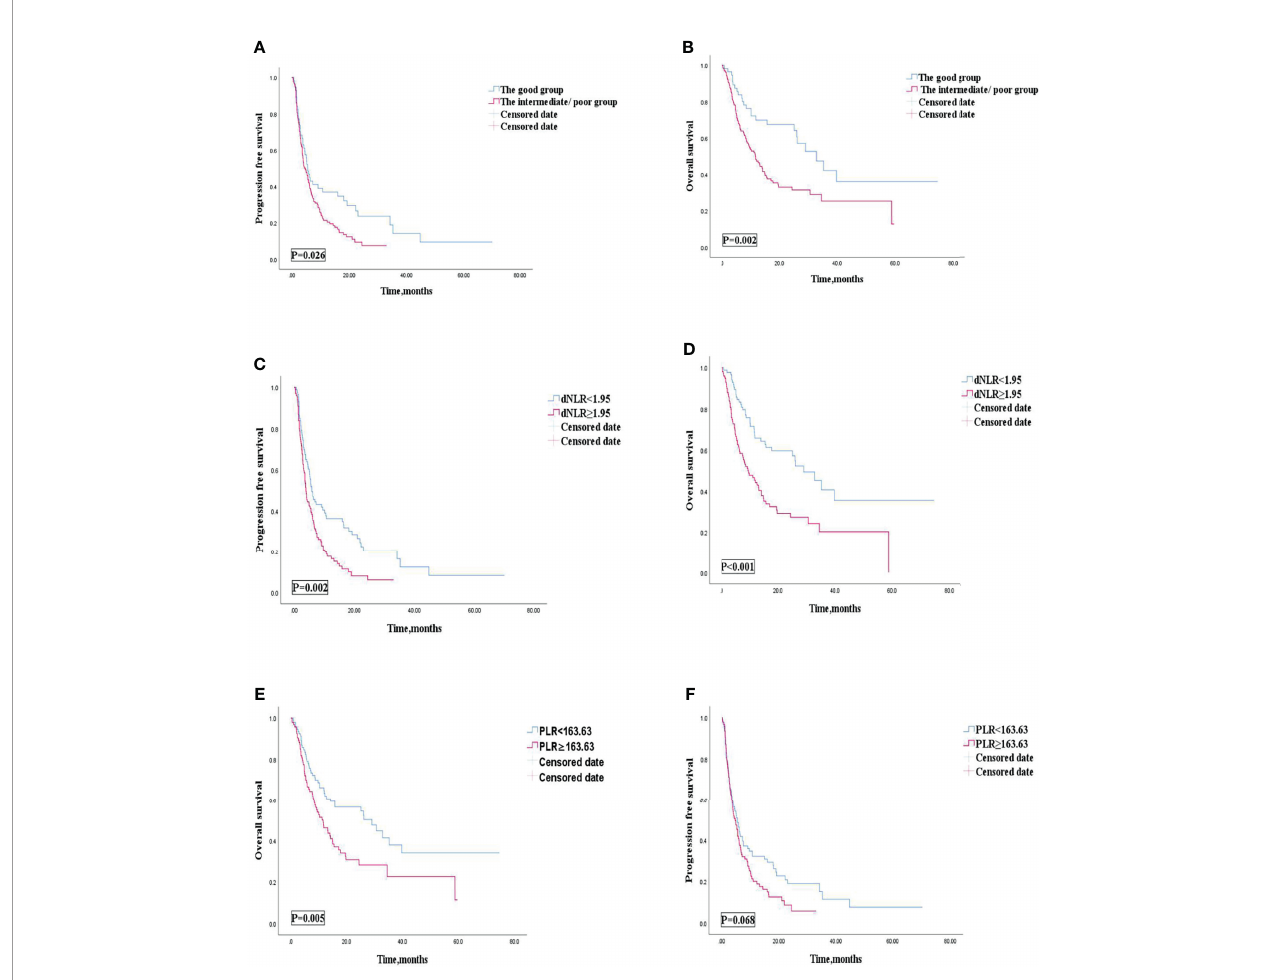
FIGURE 6 | PFS (A) and OS (B) of the good group and the intermediate/poor group of patients with AGC, receiving ICIs combined with other therapies cohort, OS (C) and PFS (D) of the dNLR of patients with AGC, receiving ICIs combined with other therapies cohort, and OS (E) and PFS (F) of the PLR of patients with AGC, receiving ICIs combined with other therapies cohort. PFS, progression-free survival; OS, overall survival; ICIs, immune checkpoint inhibitors; dNLR, derived neutrophil ‐ to ‐ lymphocyte; PLR, platelet – lymphocyte